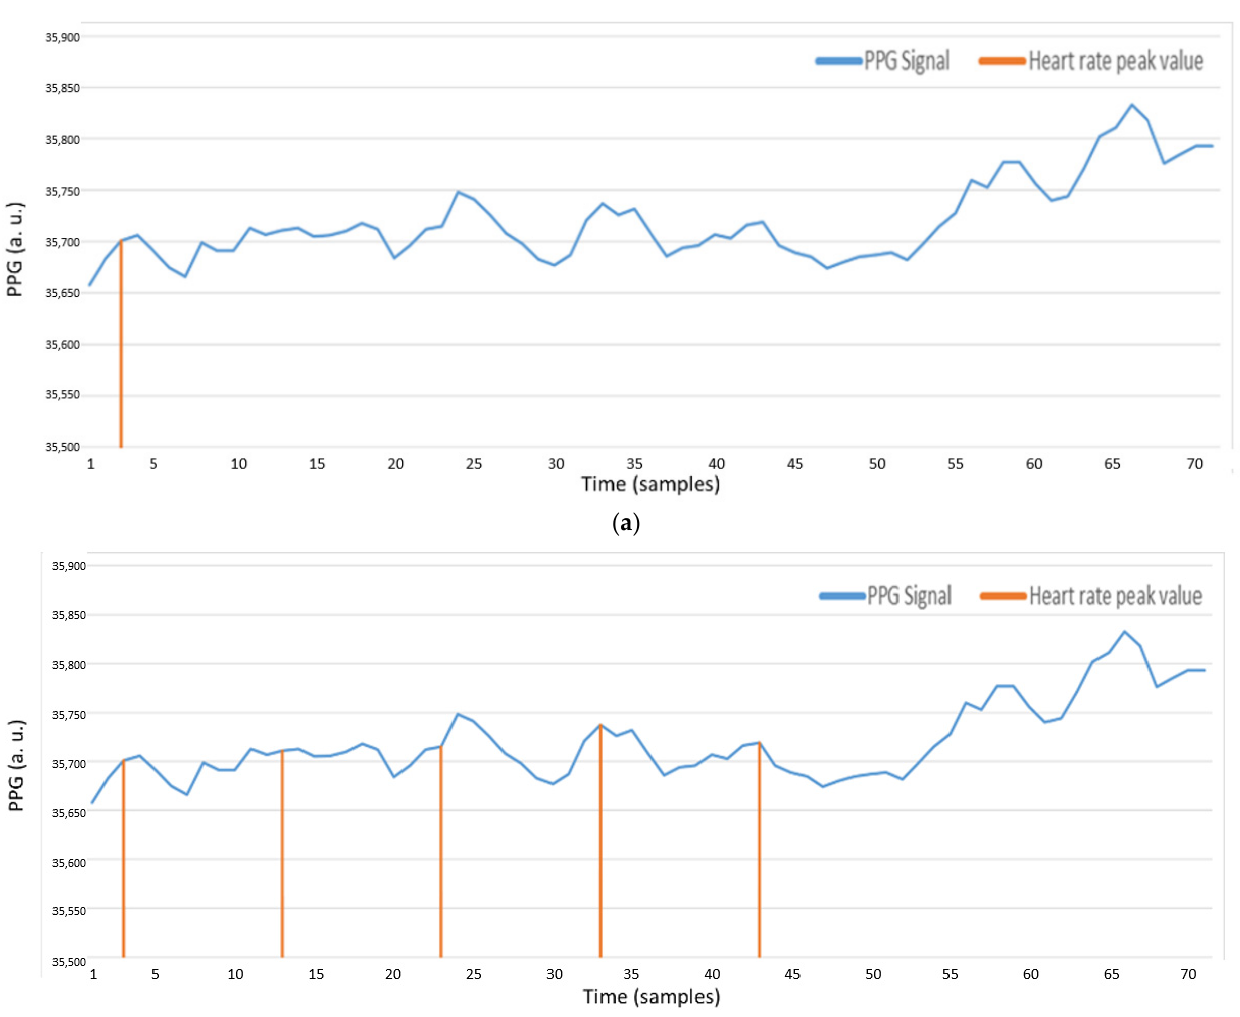
Figure 23. ( a ) AMPD algorithm with Laplacian (AMPD Threshold = 6/𝐿 , L = 7); ( b ) AMPD algorithm with Laplacian (AMPD Threshold = 2/𝐿 , L = 7).